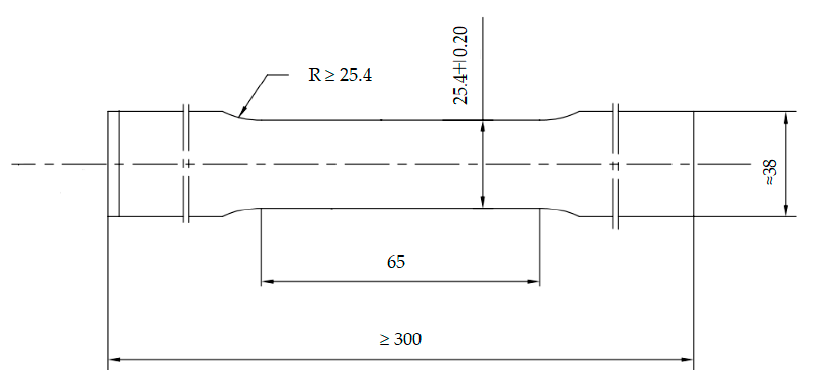
Figure 2. Geometry and dimensions of tensile specimen.